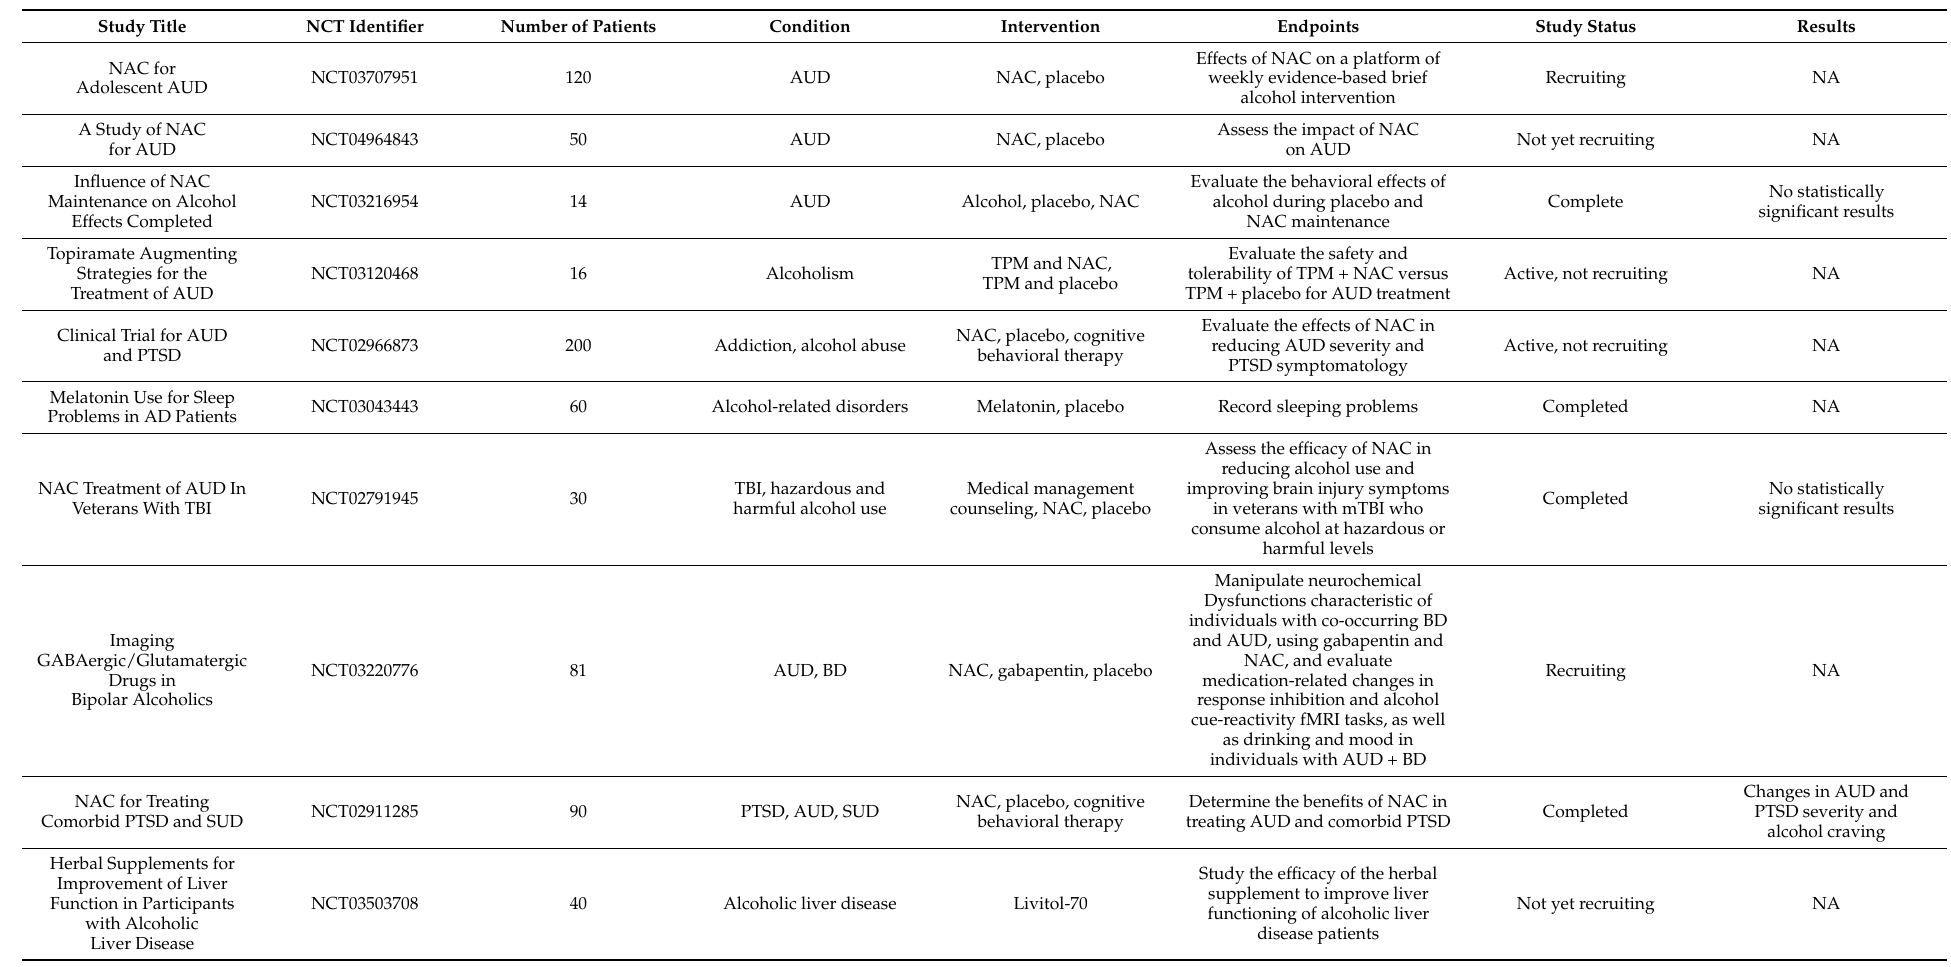
Table 7. Registered clinical